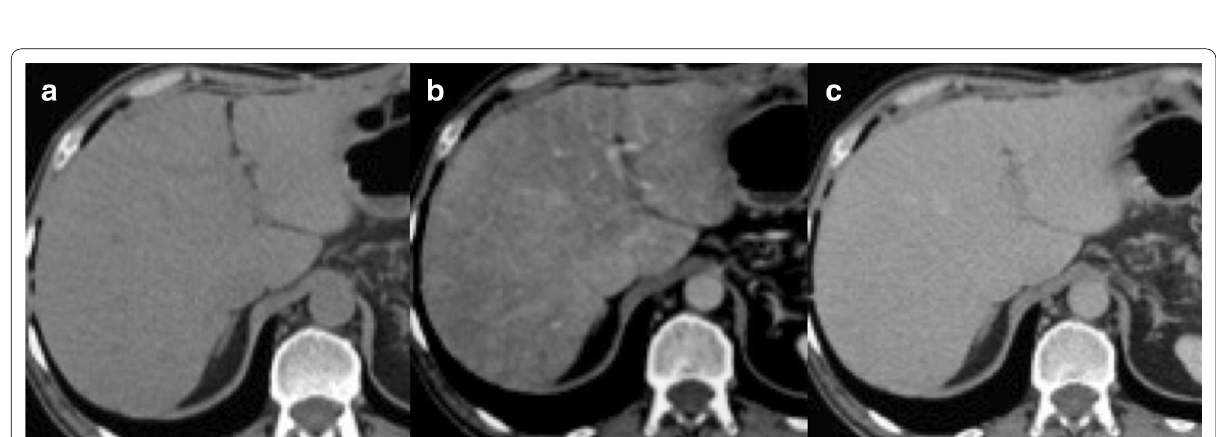
Fig. 15 64-year-old man with history of left hemicolectomy for colon carcinoma and liver metastases treated with oxaliplatin. Contrast enhanced CT on precontrast ( a ), portal venous ( b ) and delayed ( c ) phases demonstrates a patchy liver enhancement with a mosaic appearance on portal venous phase, mainly in the periphery of the right lobe, with normal parenchymal enhancement on subsequent delayed phase. These findings are consistent with oxaliplatin-induced sinusoidal obstruction syndrome in its diffuse form